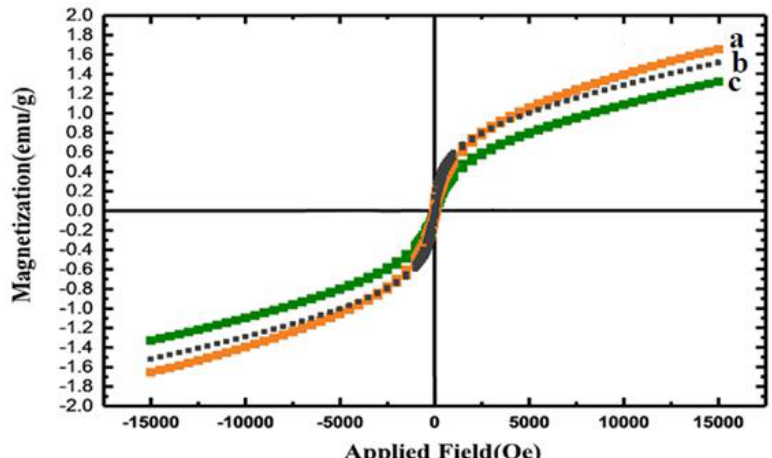
O /NiO, (b) Co O /NiO@GQDs and (c) Co 3 4 3 4